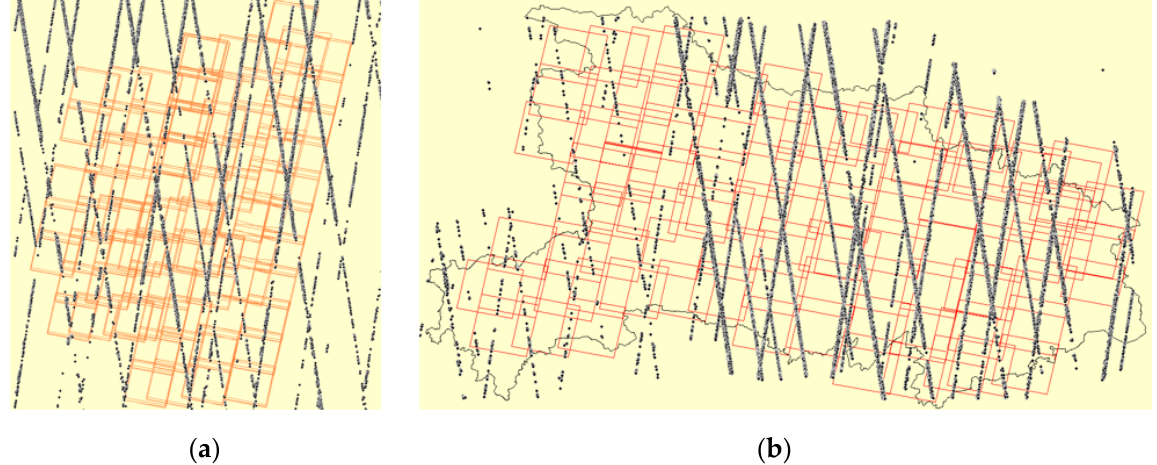
Remote Sens. 2021 , 13 , x FOR PEER REVIEW 13 of 19 Figure 8. Points in optical and SAR image. ( a ) point a, ( b ) point b. Figure 8. Points in optical and SAR image. ( a ) point a, ( b ) point b.